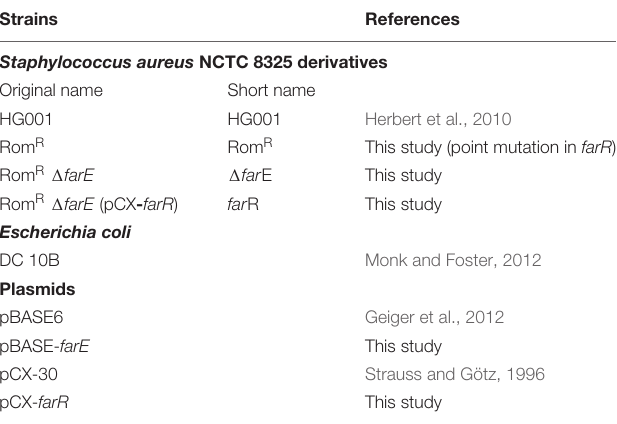
TABLE 1 | Strains and plasmids used in this study.